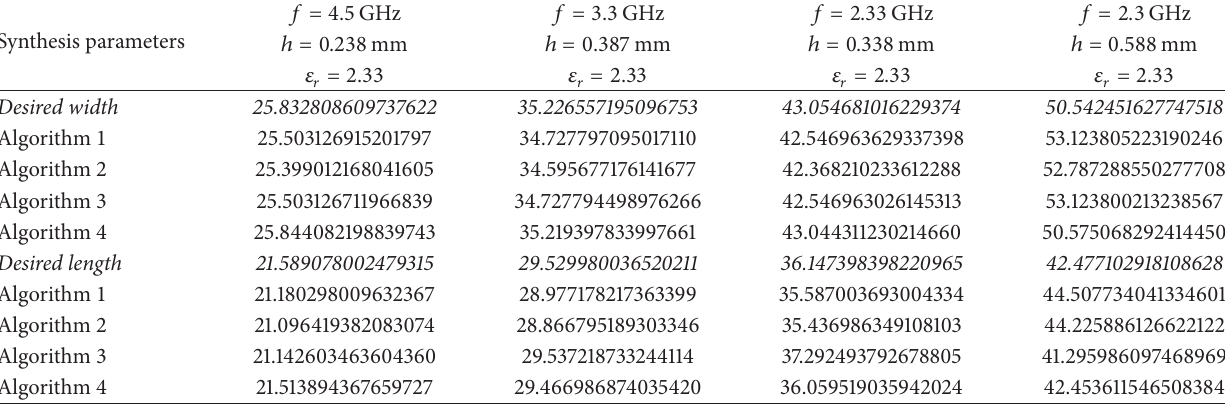
Table 3: Comparison of the desired and approximated width and length for the four